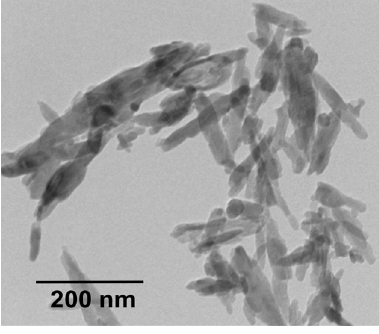
Figure 14. Transmission electron micrograph of nHA rods. Reproduced from [63] with permission of MDPI.